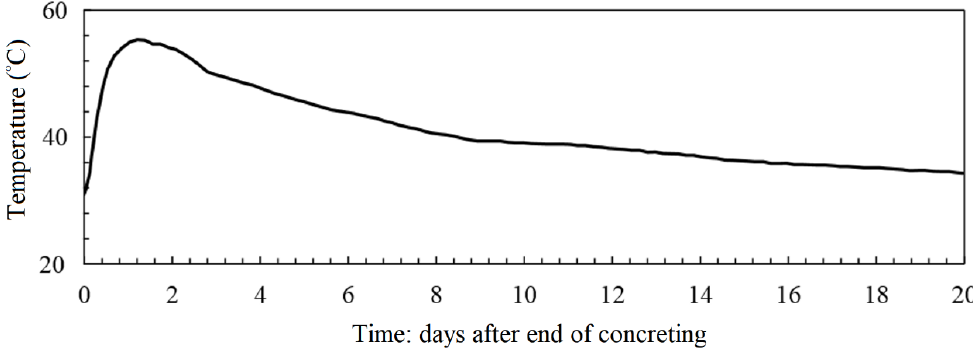
Figure 10. Experimental profile of temperature change with time